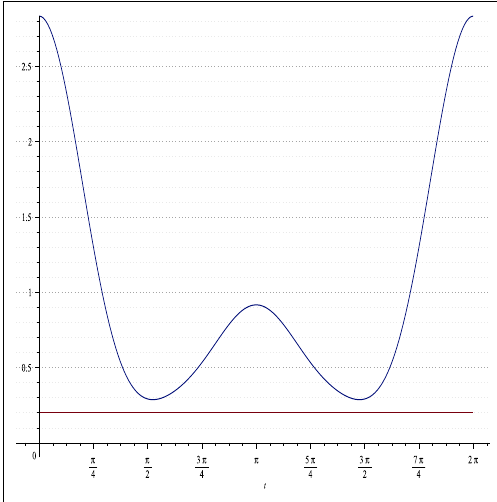
(cid:16) (cid:17) e it for t ∈ [ 0,2 π ] , and v =